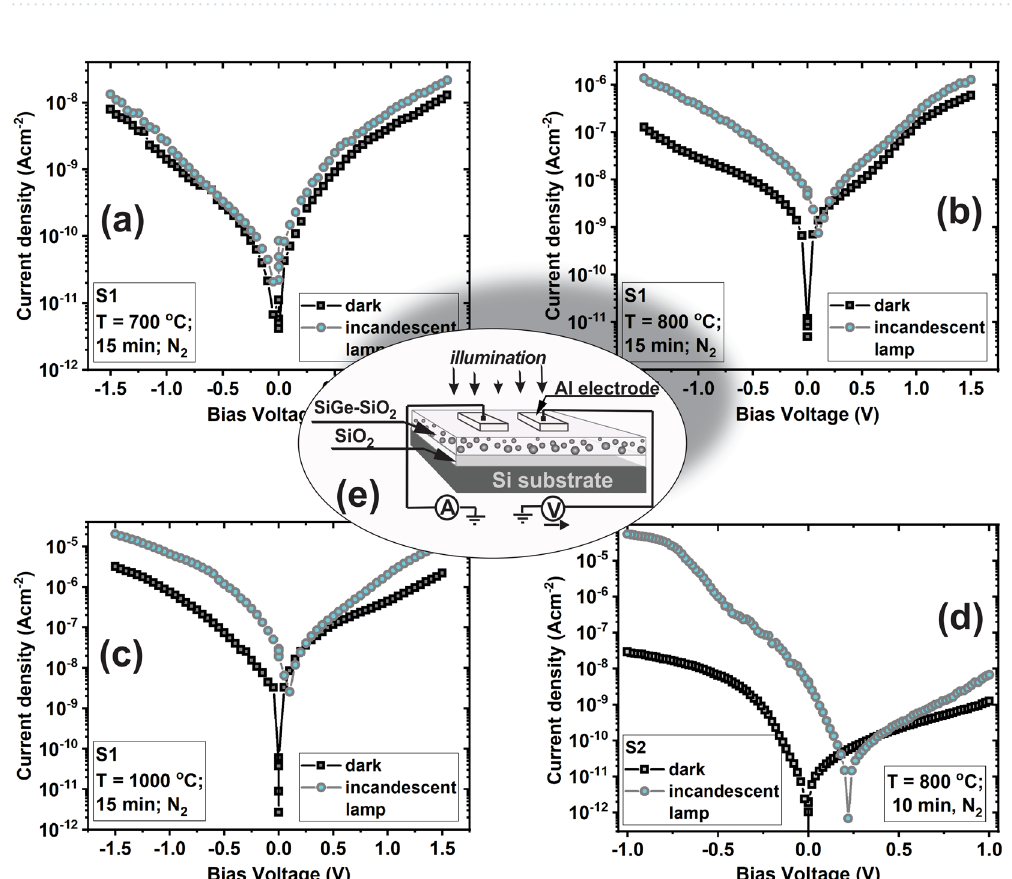
Figure 7. J-V characteristics obtained in dark and under illumination with an incandescent lamp on S1 (25%Si25%Ge:50%SiO 2 ) film annealed at ( a ) 700 °C, ( b ) 800 °C and ( c ) 1000 °C and on S2 (5%Si45%Ge:50%SiO 2 ) film annealed at ( d ) 800 °C. ( e ) Schematic representation of the investigated structures and measurement